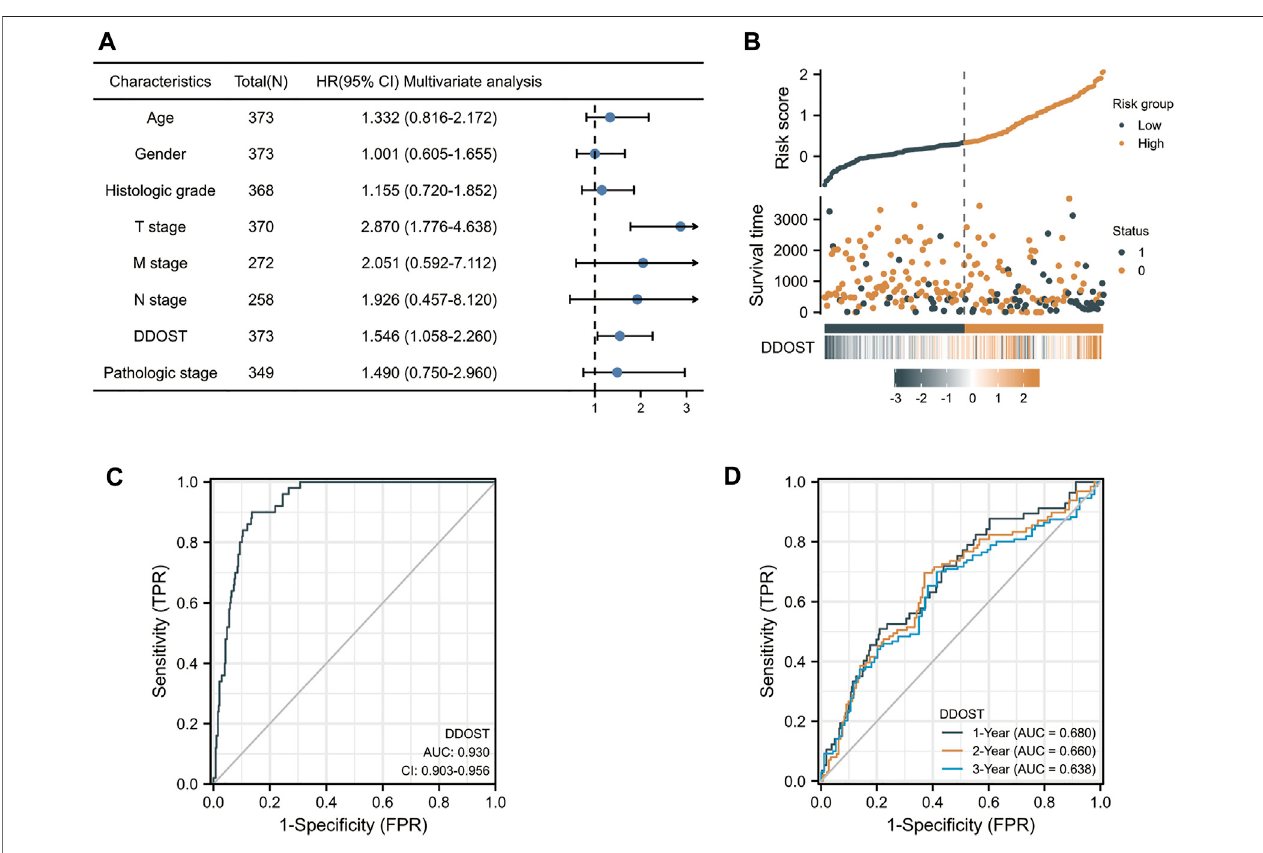
FIGURE 5 | The prognostic value of DDOST in LIHC. (A) Multivariate Cox regression visualized in the forest plot (B) DDOST expression distribution and survival status. 0: dead, 1: alive. (C) Diagnostic ROC curve of DDOST. (D) Time-dependent ROC curve of DDOST.